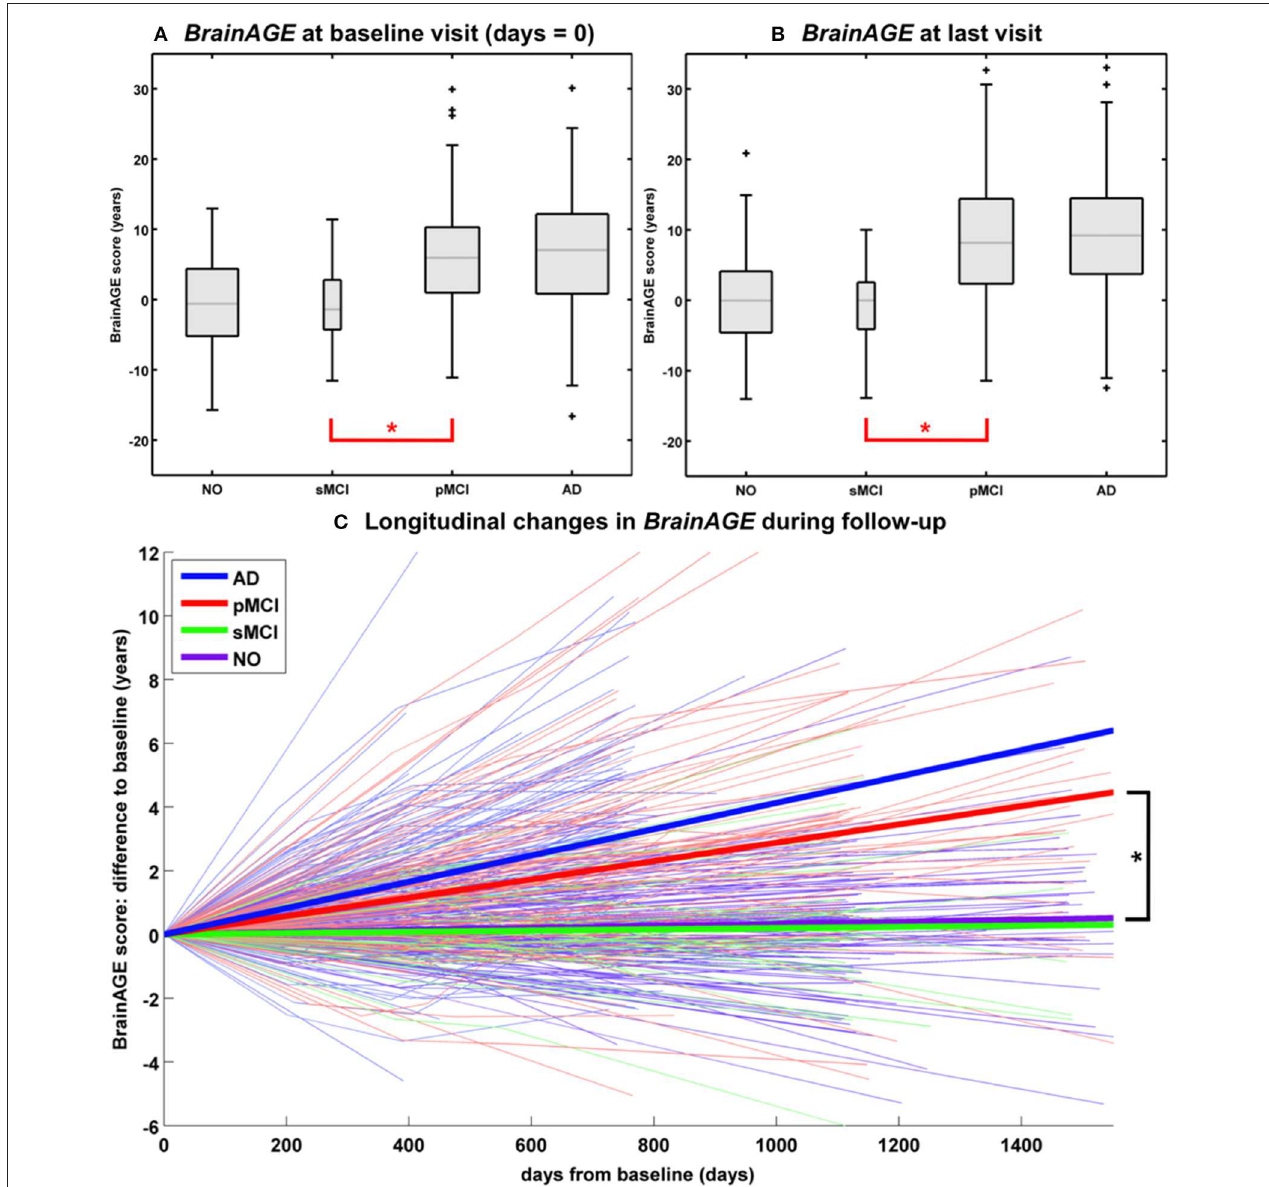
FIGURE 5 | Longitudinal BrainAGE . Box plots of (A) baseline BrainAGE scores and (B) BrainAGE scores of last MRI scans for all diagnostic groups. Post-hoc t-tests showed significant differences between NO/sMCI vs. pMCI/AD (* p < 0.05) at both time measurements. (C) Longitudinal changes in BrainAGE scores for NO, sMCI, pMCI, and AD. Thin lines represent individual changes in BrainAGE over time; thick lines indicate estimated average changes for each group. Post-hoc t-tests showed significant differences in the longitudinal BrainAGE changes between NO/sMCI vs. pMCI/AD (* p < 0.05). [Figures and legend reproduced from Franke et al. (45), with permission from Hogrefe Publishing,